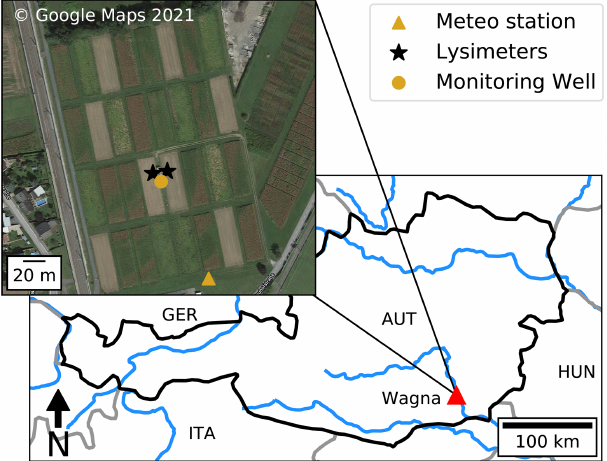
Figure 1. Map of the case study area with the locations of the lysimeters, the meteorological station, and the groundwater mon- itoring well used in this study.